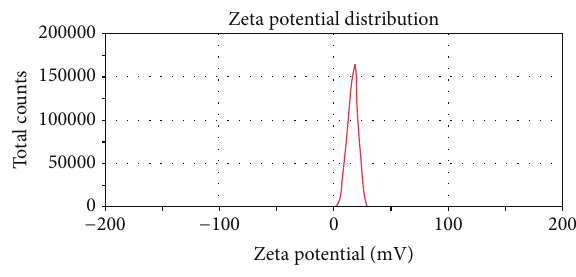
Figure 5: Zeta of RGD-PTX liposomes.